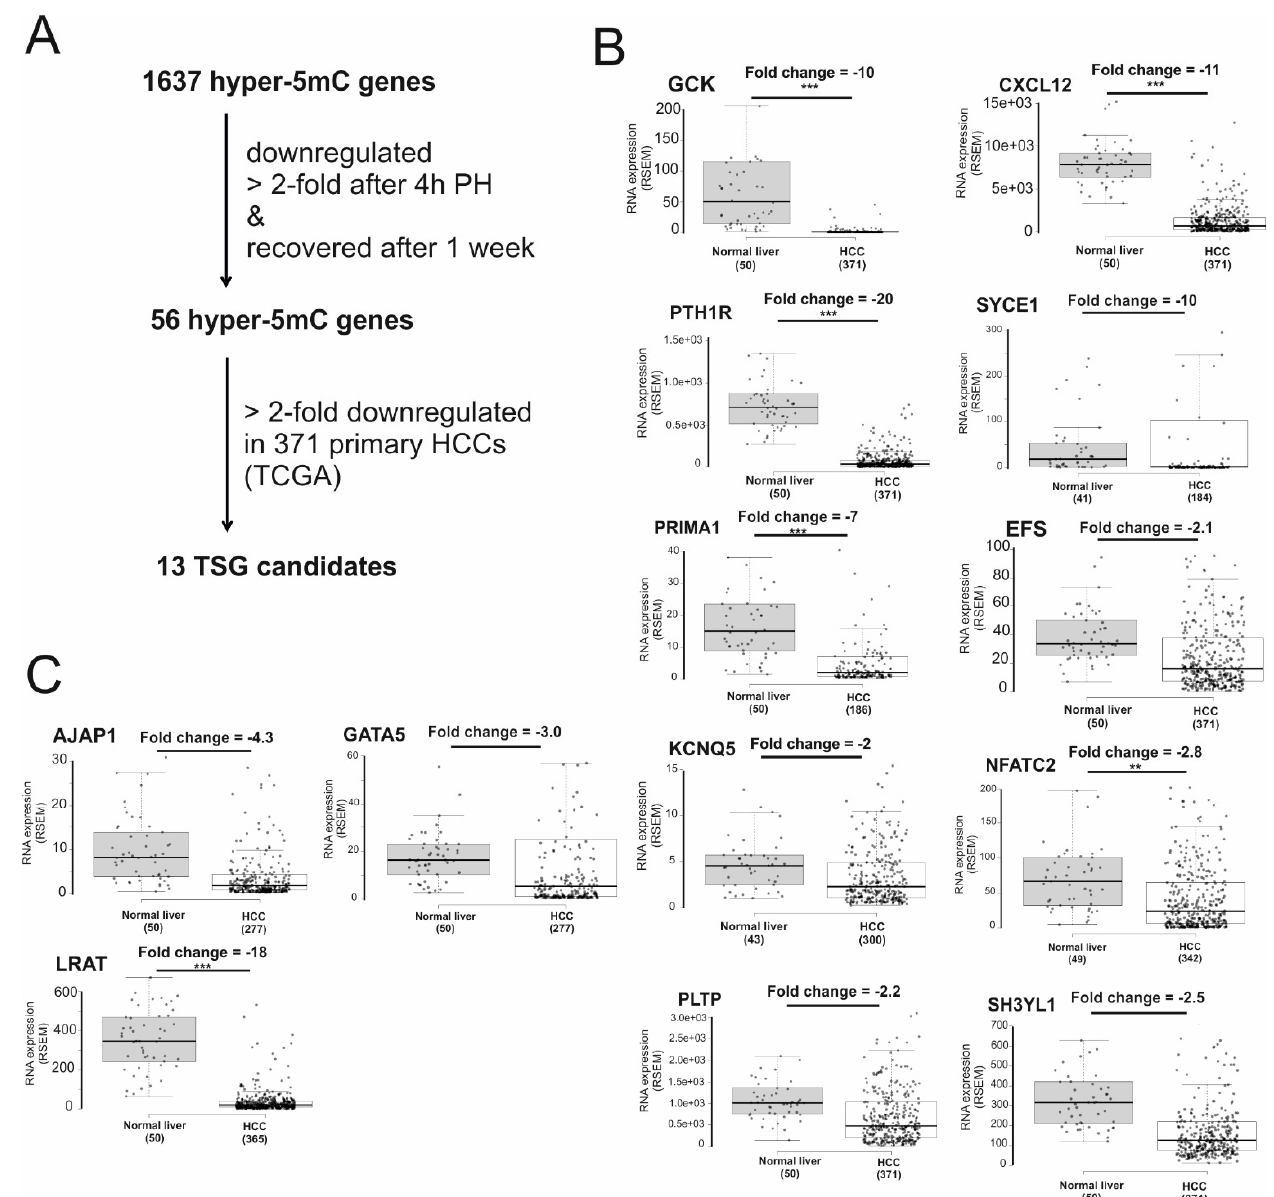
Figure 2. Identification of tumor suppressor gene (TSG) candidates. ( A ) Strategy to identify potential TSGs: gene expression of 1637 hypermethylated genes before and four hours (4h) after partial hepatectomy (PH) was examined using previously published RNA-Seq data (GSE95135). To narrow TSG candidates further, the expression of 56 genes downregulated after PH in 371 primary HCCs was examined. ( B , C ) Boxplot showing gene expression of 13 TSG candidates in normal liver versus primary HCC: mRNA expression generated by the Cancer Genome Atlas (TCGA) and fold change (normal liver versus HCC) were retrieved from Firebrowse (http://firebrowse.org/, accessed on 3 February 2021) data portal. **: p -value < 0.0001; *** p -value < 0.0000001. RSEM: RNA-Seq by expectation–maximization [35].